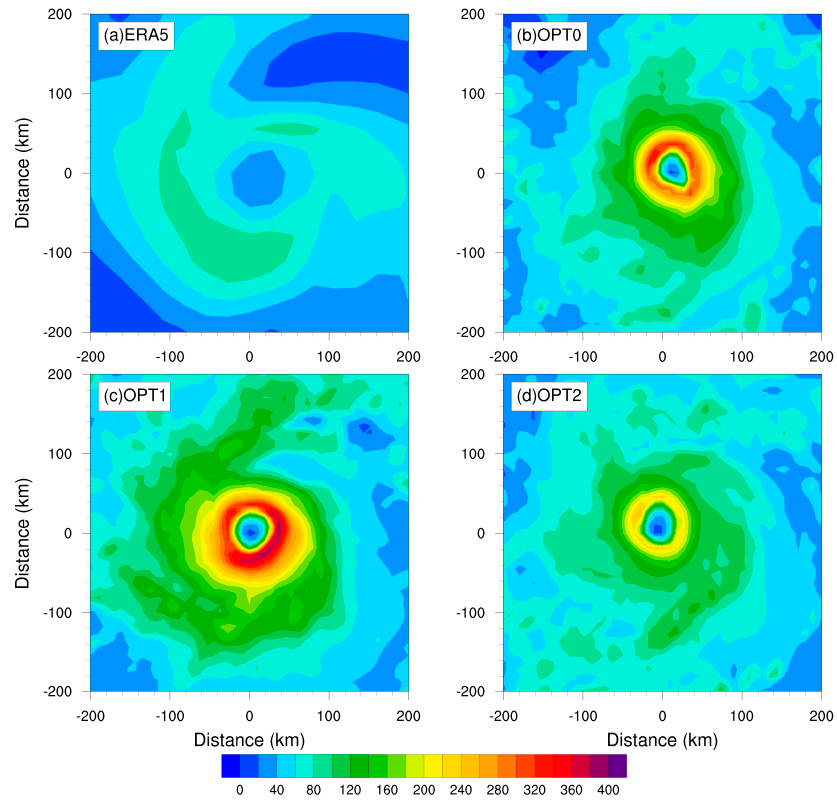
Figure 6. As in Figure 5 but for surface sensible heat flux (unit: W m − 2 ).